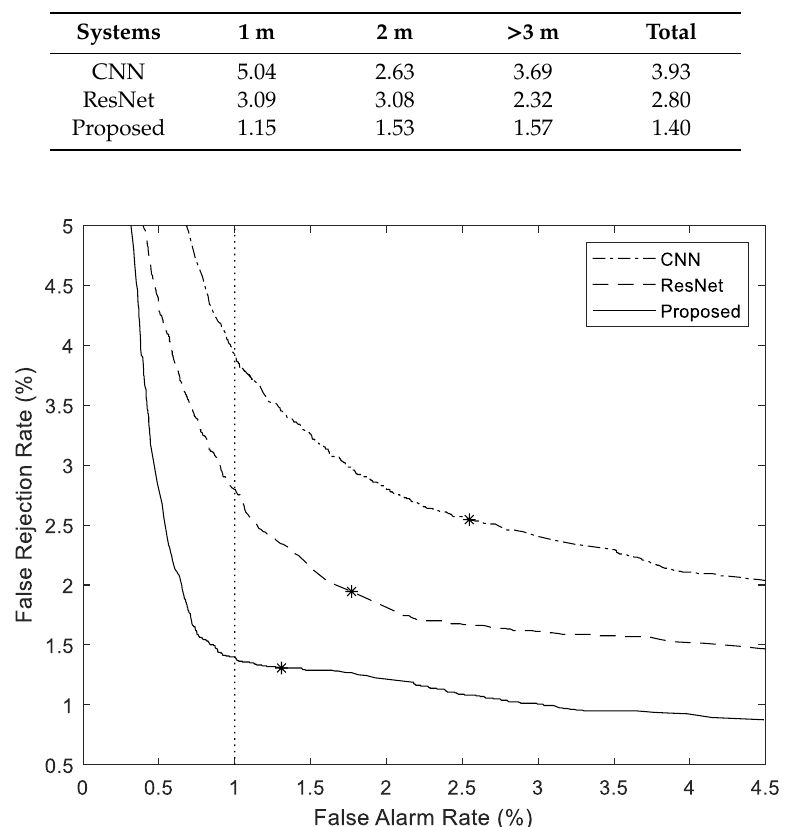
Table 8. Comparison of FRR (%) at 1.0% FAR over the di ff erent speaker distances from the microphone.